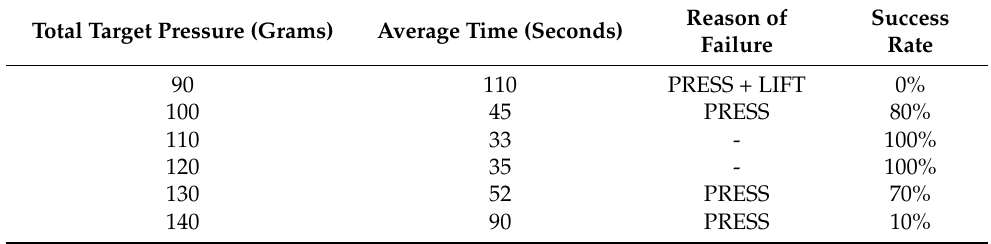
Table 2. Results of single robot approach and lift process changing total target pressure. Total Target Pressure